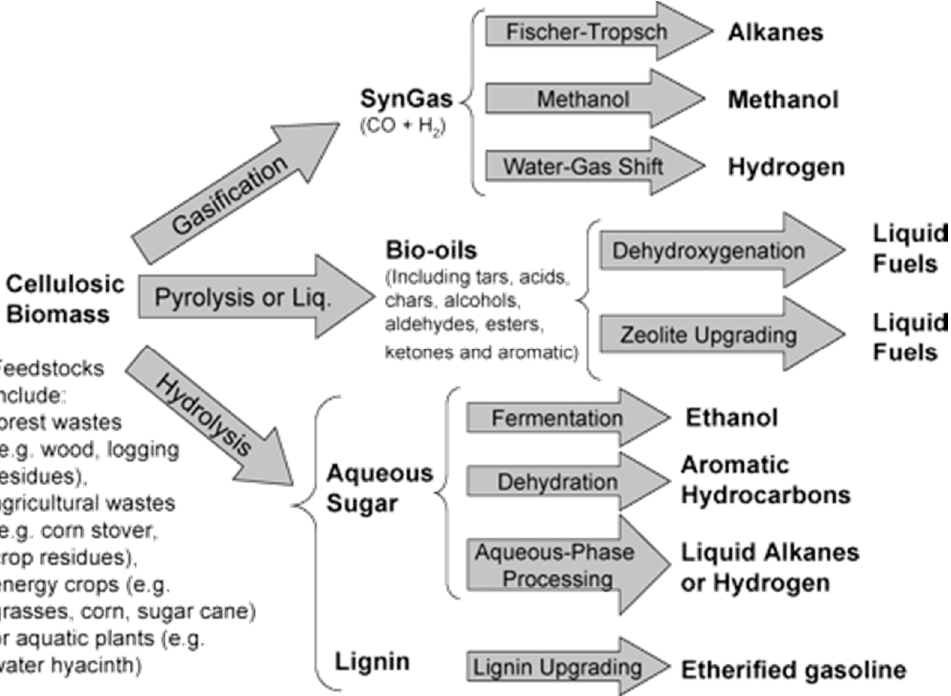
Figure 1. Different routes for fuel production from biomass. Reprinted from reference [15]. Figure 1. Di ff erent routes for fuel production from biomass. Reprinted from reference